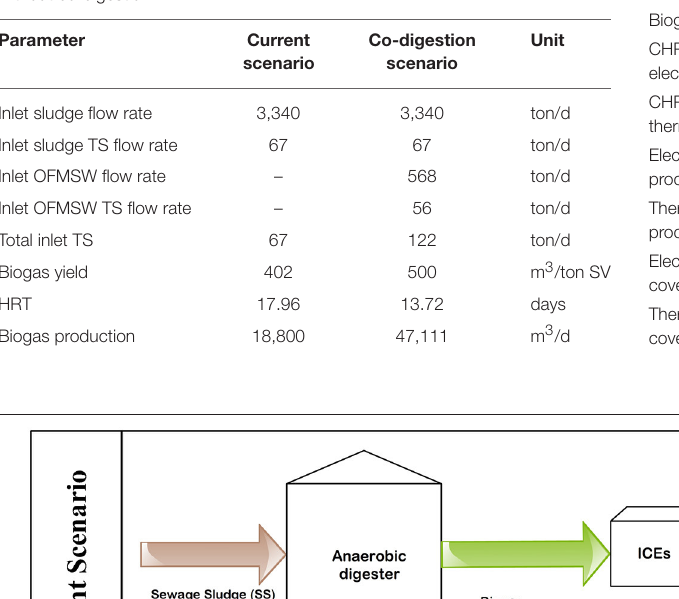
TABLE 9 | Mass balance at the digester inlet and biogas production with and without co-digestion.